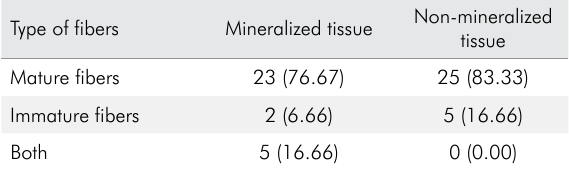
Table. Maturation of fibers at each lesion site. n